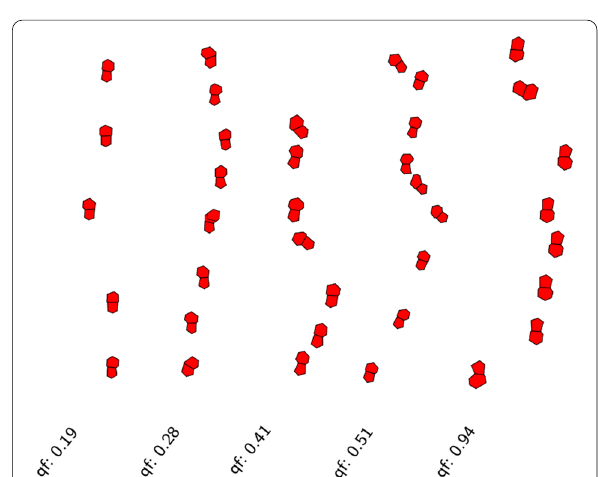
Fig. 3 Attribution of a quality factor qf for the extracted defect pair strings based on how straight the lines are and on the angles between pairs of defect pairs. The lower the number the better